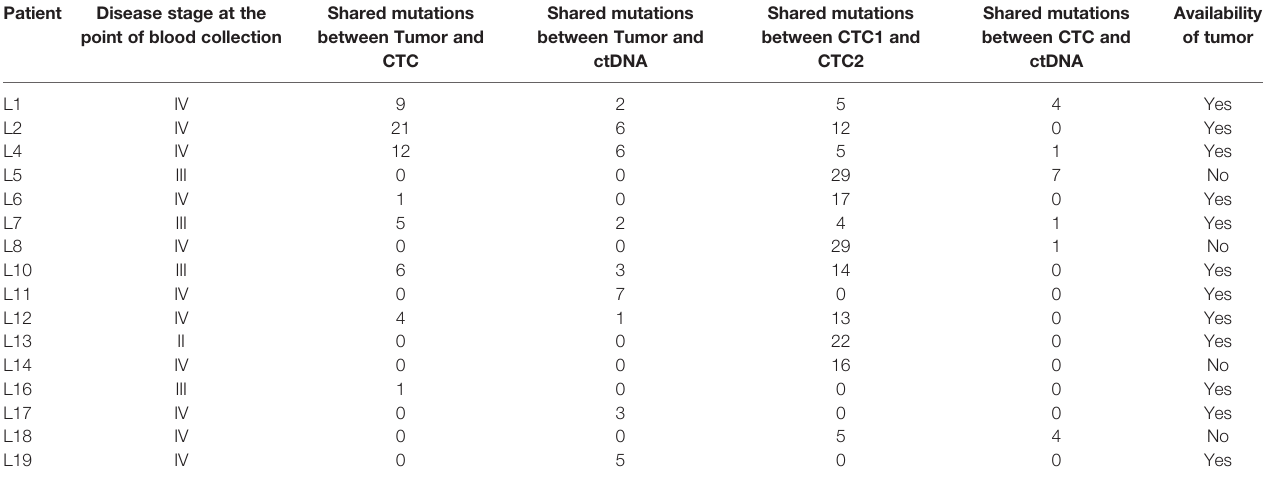
TABLE 3 | The tabulation of the mutations shared between tumor, CTCs and ctDNA for lung cancer samples. Patient Disease stage at the point of blood collection